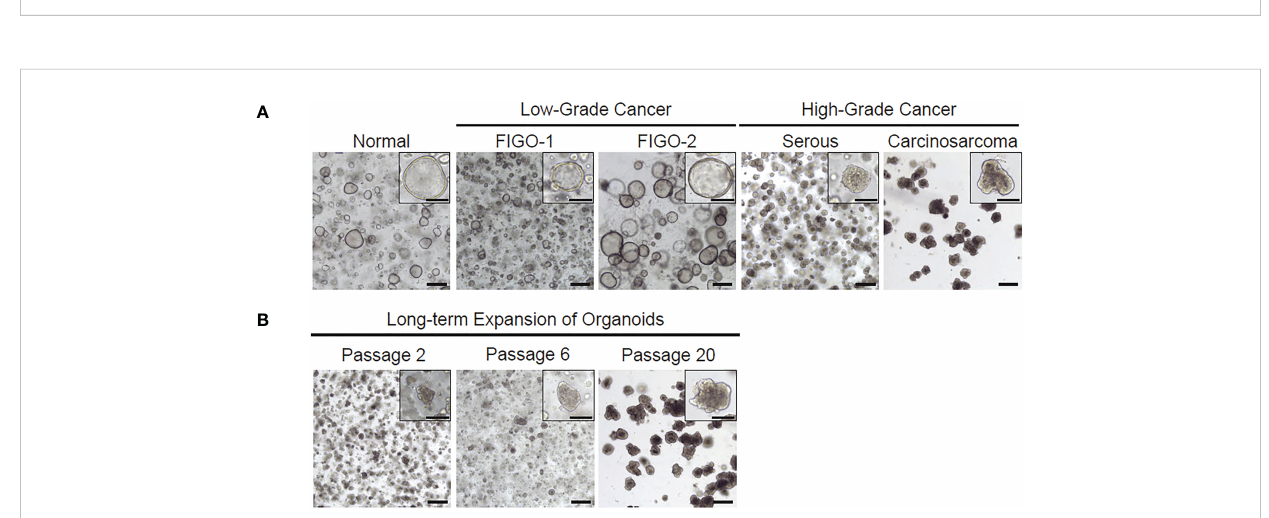
FIGURE 3 Representative images of patient-derived organoids from normal endometrium, low-grade cancer or high-grade cancer. (A) Both low and high grade histologic subtypes are able to be cultured and maintained through several passages. (B) Organoids can survive in culture over several passages.